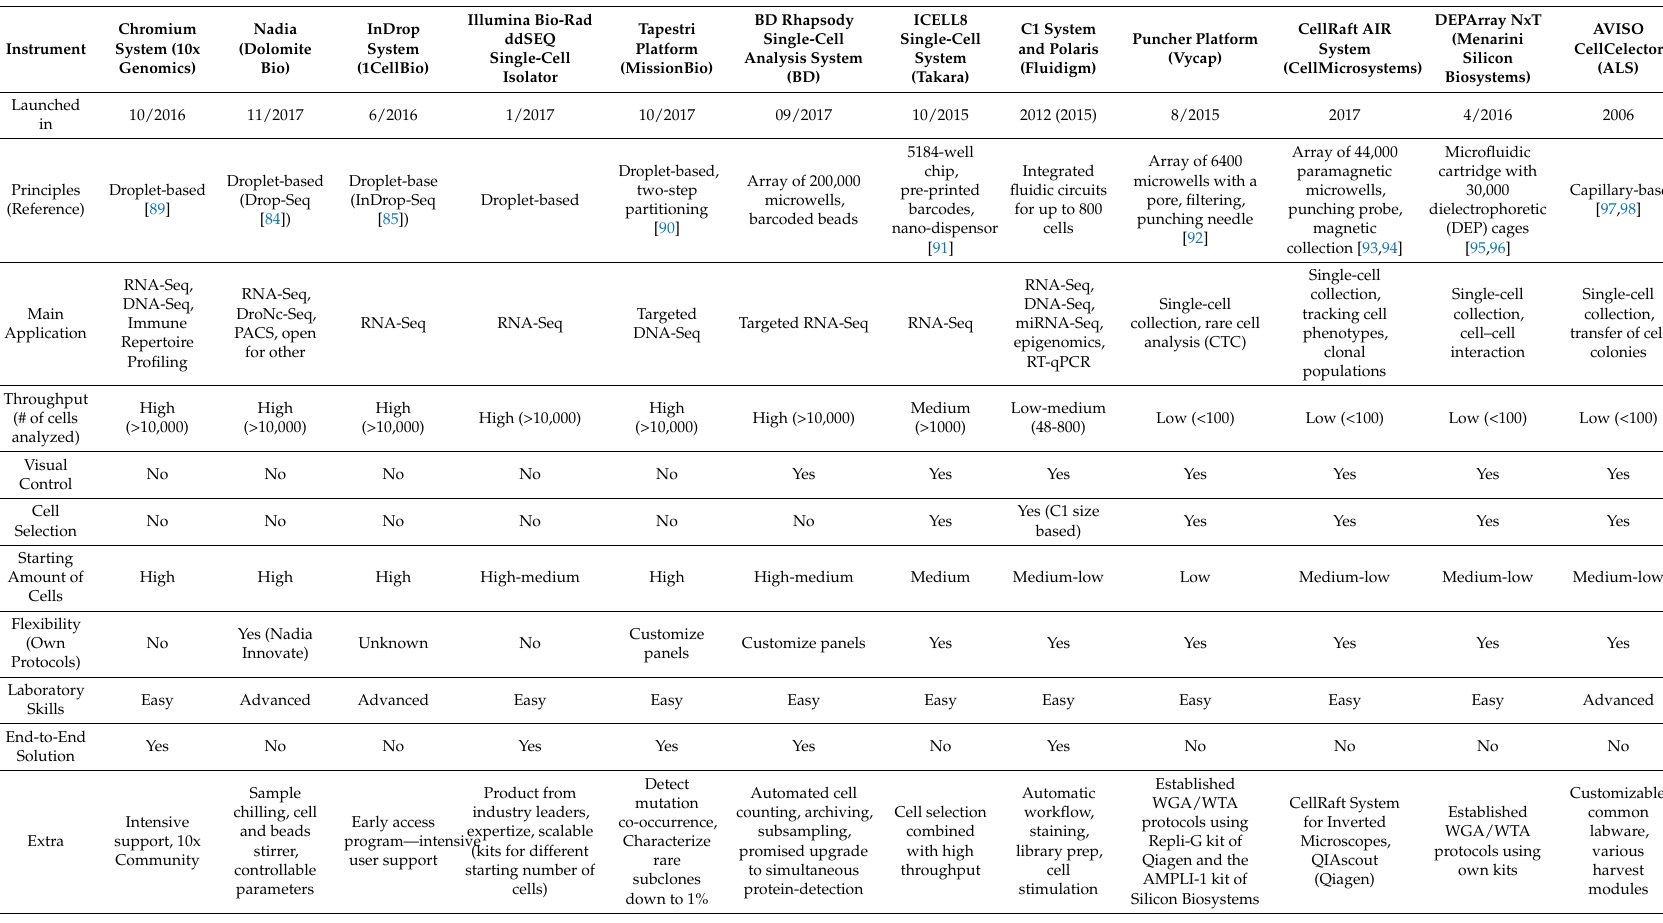
Table 2. Overview of commercially available instruments for single-cell collection and